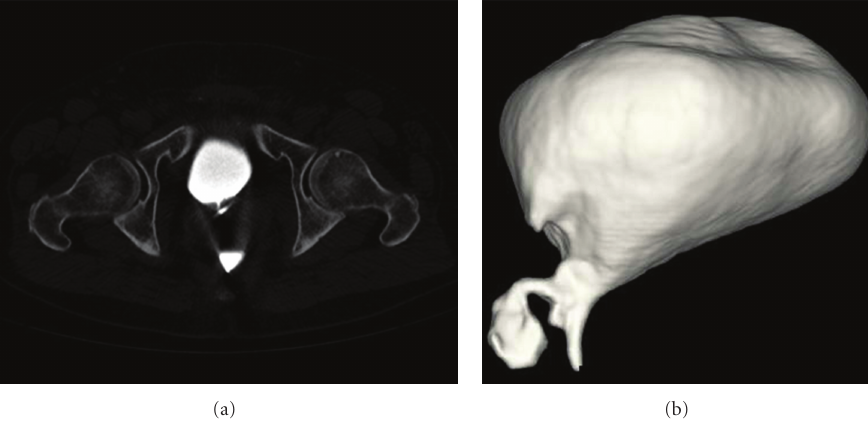
Figure 2: Pelvic CT scan with VR reconstruction. Pelvic CT scan was acquired before emptying the bladder of the contrast media, in order to confirm and to be sure that the bladder was not involved in the problem and that only the urethra was a ff ected by the fistula. (a) Axial plane. (b) VR reconstruction. The latter allows to see very well the fistolous tract that connects the bladder to the